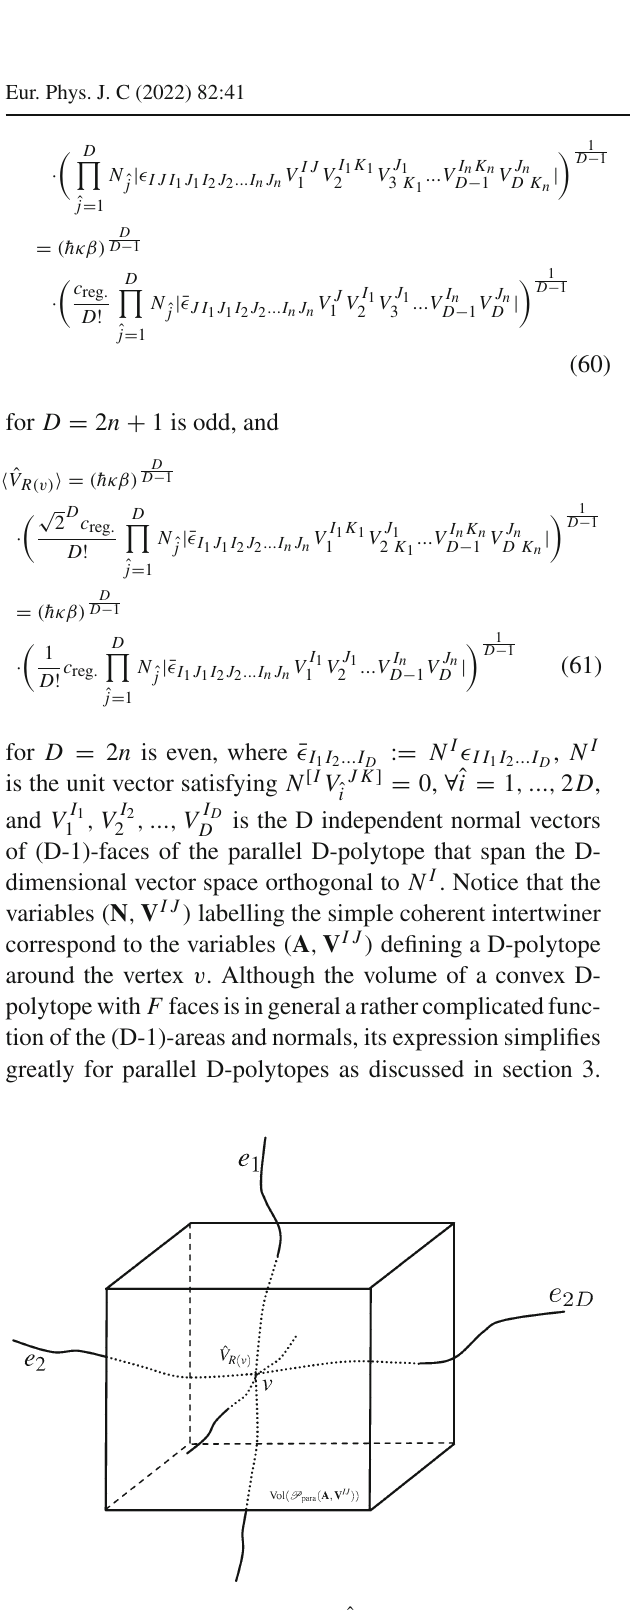
Fig. 3 The usual D-volume operator ˆ V R (v) is defined by regulariz- ing the classical expression of the D-volume adapted to a given graph γ , and an undetermined pre-factor c reg. appears in the expression of ˆ V R (v) . The semiclassical consistency requires that the expectation value of ˆ V R (v) with respect to || N , V IJ (cid:19) p . should be equal to the volume Vol ( P para ( A , V IJ )) oftheclassicalD-parallelpolytope P para ( A , V IJ )